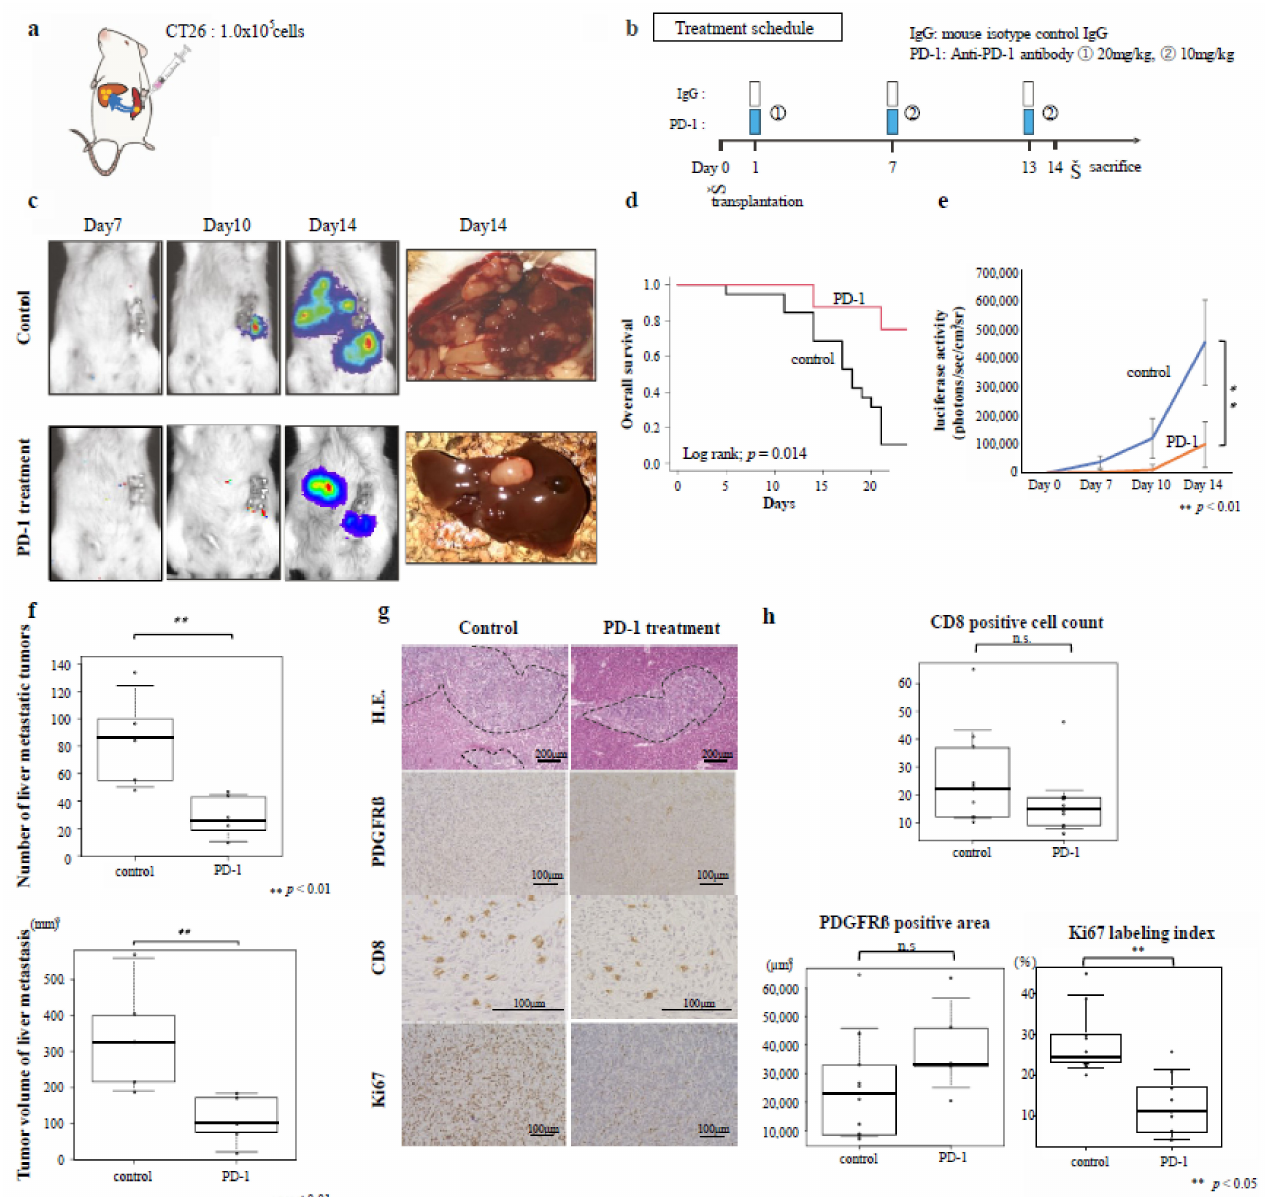
Figure 2. Anti-PD-1 antibody treatment and inflamed-type colon cancer liver metastasis. The inhibitory effect of anti-PD-1 antibody on liver metastasis was evaluated using a mouse model of inflamed-type colon cancer. ( a ) Tumor transplantation design and transplanted cell content. ( b ) Treatment schedule. Inflamed control, n = 8; Inflamed PD-1, n = 8. ( c ) Changes in tumors over time as observed by luminescence imaging (Days 7, 10, and 14 post-transplantation) and gross observation of the tumors with the naked eye after sacrifice on day 14 post-transplantation. ( d ) Kaplan–Meier survival curve. Control, n = 19; PD-1, n = 8. ( e ) Quantification of changes over time according to luciferase activity. ( f ) Tumor number and volume of metastasized tumors. ( g ) Representative micrographs of hematoxylin and eosin (HE)-stained (100 × magnification) and immunostained (200 × magnification) tumors. Immunostaining was performed using PDGR β -, CD8-, and Ki-67-specific antibodies. ( h ) Quantification of the number of CD8-positive cells, PDGFR β -positive area, and Ki67-positive cell percentage of metastatic tumors. n.s. = not